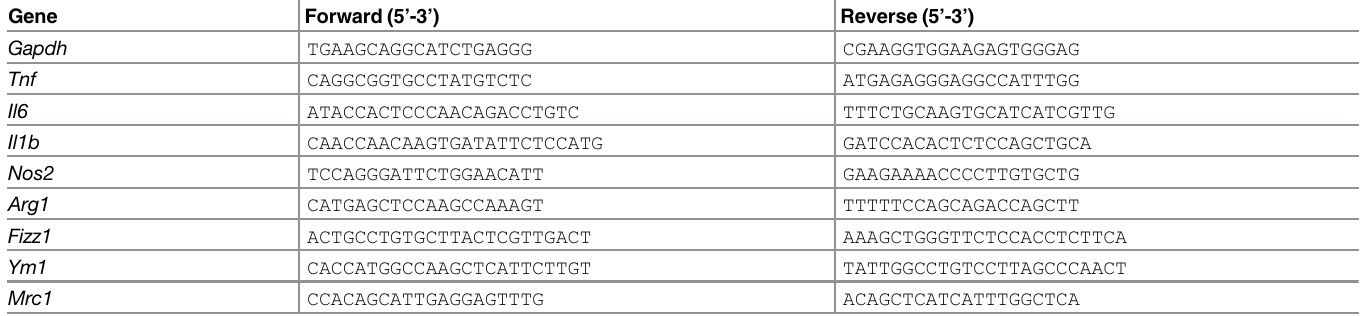
Table 1. Oligodeoxynucleotide primers used in qPCR